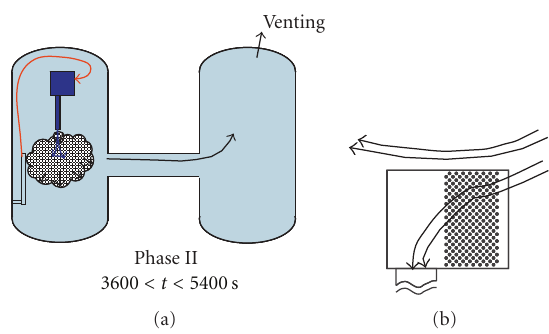
Figure 28: Suggested flow pattern for 3600 < t < 5400 s.